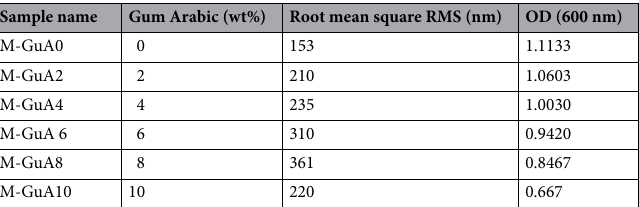
Table 1. Concentration of Gum Arabic, Surface roughness (RMS) and Optical density in CA/VTES-GO polymer matrix.